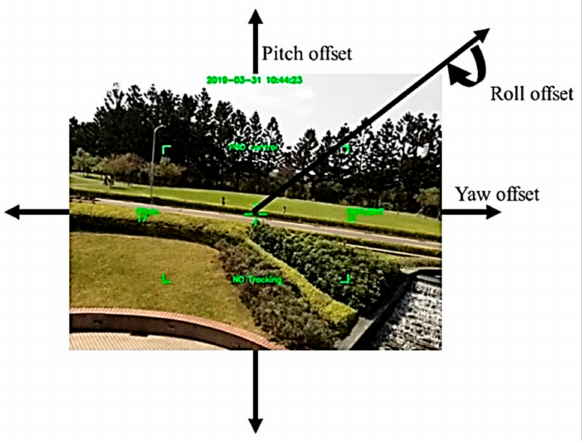
Figure 12. Image vibration compensation with filtering through the gyroscope.